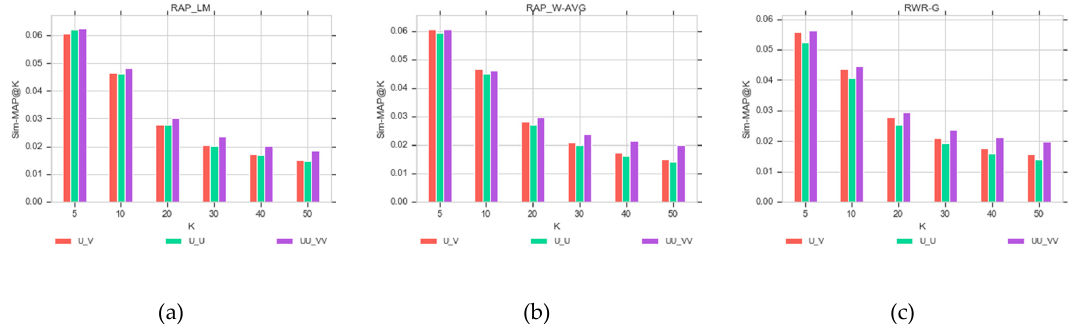
Figure 7. Values of Sim-MAP@K index (vertical axis) of CLGRW in three group recommendation strategies: ( a ) RAP_LM, ( b ) RAP_W-AVG, and ( c ) RWR-G using different numbers of recommendations (horizontal axis) and three graph models: U-V, U-U, and UU-VV graphs.